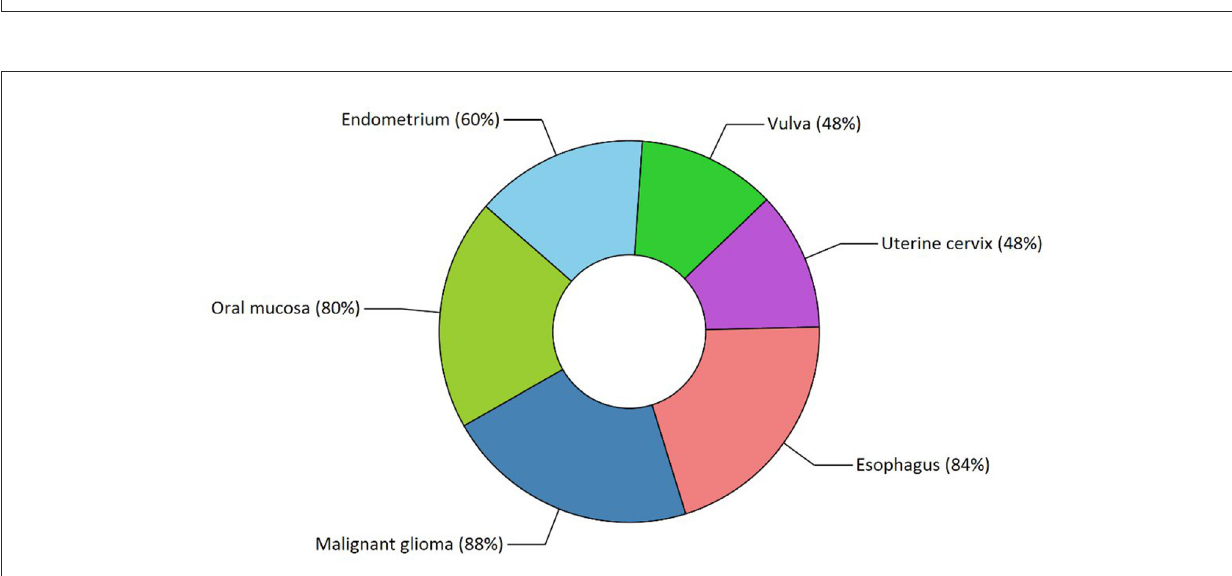
FIGURE6 Functional enrichment analysis revealed sites of expression of osteosarcoma genes. The various highlighted portions show different sites of